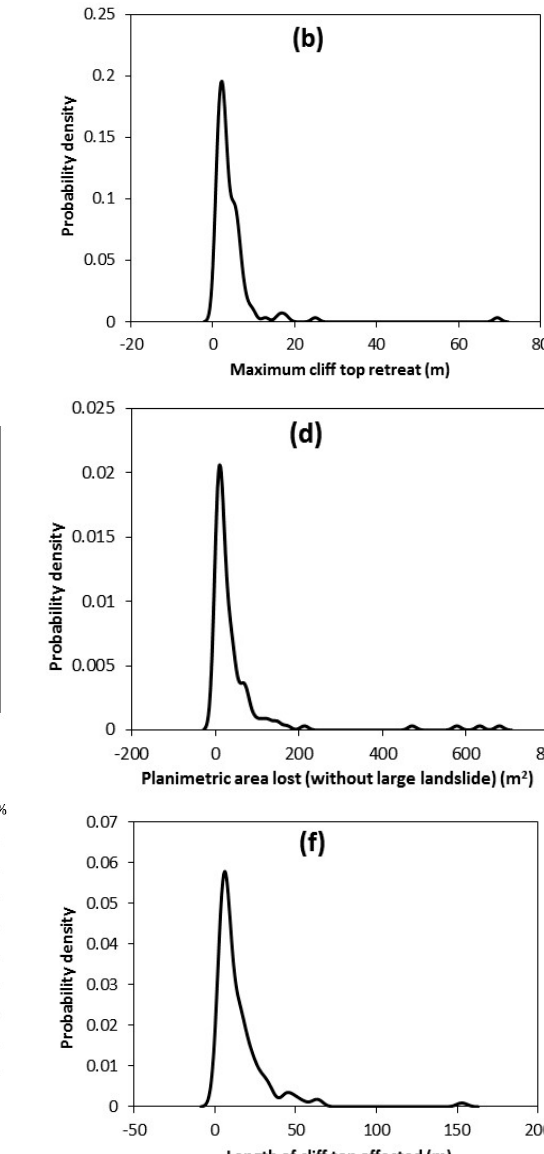
Figure 3. Maximum cliff top retreat caused by failures against cliff height. Square indicates the large translational slide occurred in the northern end of the study area.